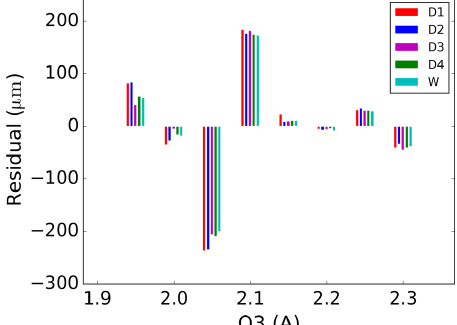
FIG. 15. Residuals for the fits in the vertical plane shown in Fig. 14.